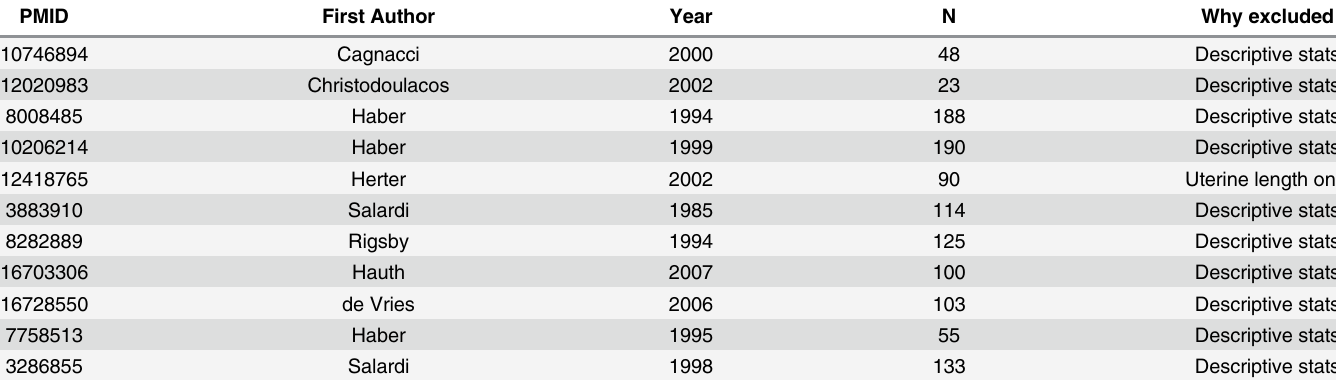
Table 2. Excluded uterine volume data summary. Pubmed ID, first author and year of publication are given for sources of non-extracted data, together with number of measurements. Each publication met the inclusion and exclusion criteria for consideration as a data source, but either contained descriptive statistics of uterine volume rather than extractable data in the form of scatter plots, or data on uterine length (rather than volume).